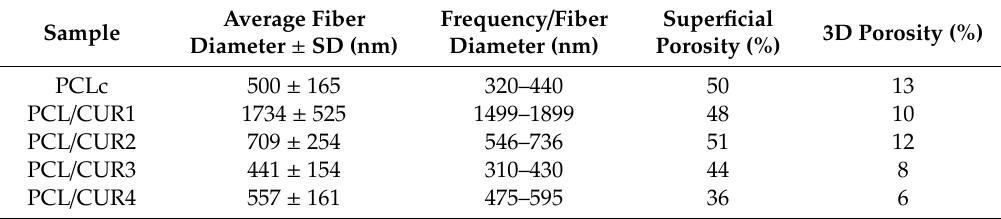
Table 3. The average fiber diameter and % porosity of PCL / CUR